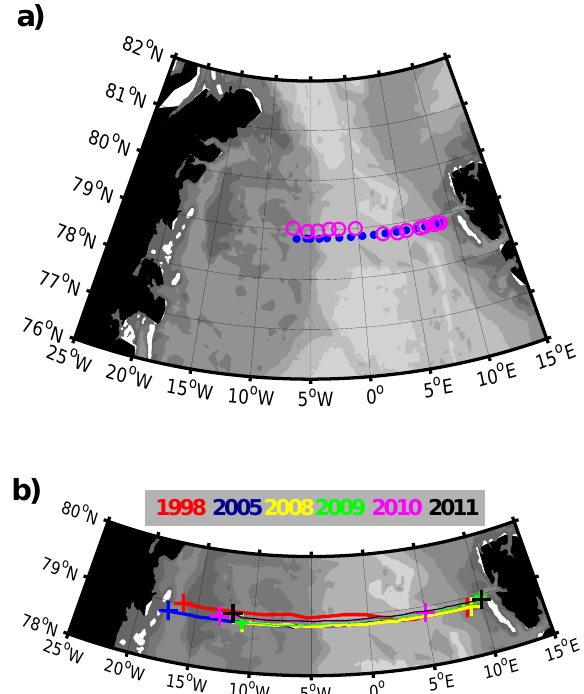
Fig. 1. Maps of (a) the locations of moorings for velocity measure- ments, for 1998 by circles, all other years by dots; (b) section lines for samples of δ 18 O, nitrate and phosphate, where different years are indicated by colour as shown (see Fig. 2 in Dodd et al., 2012, for sampling locations along each section). Bathymetry shading in gray at intervals 100, 200, 1000, 2000 and 3000m (from IBCAO, Jakobsson et al.,